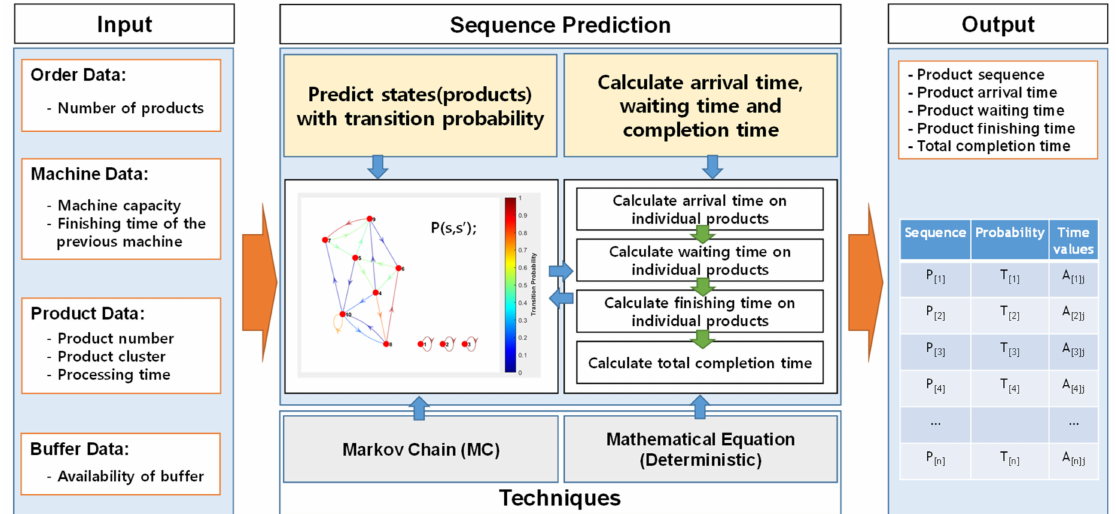
Figure 8. Concept of sequence-learning-based product sequence